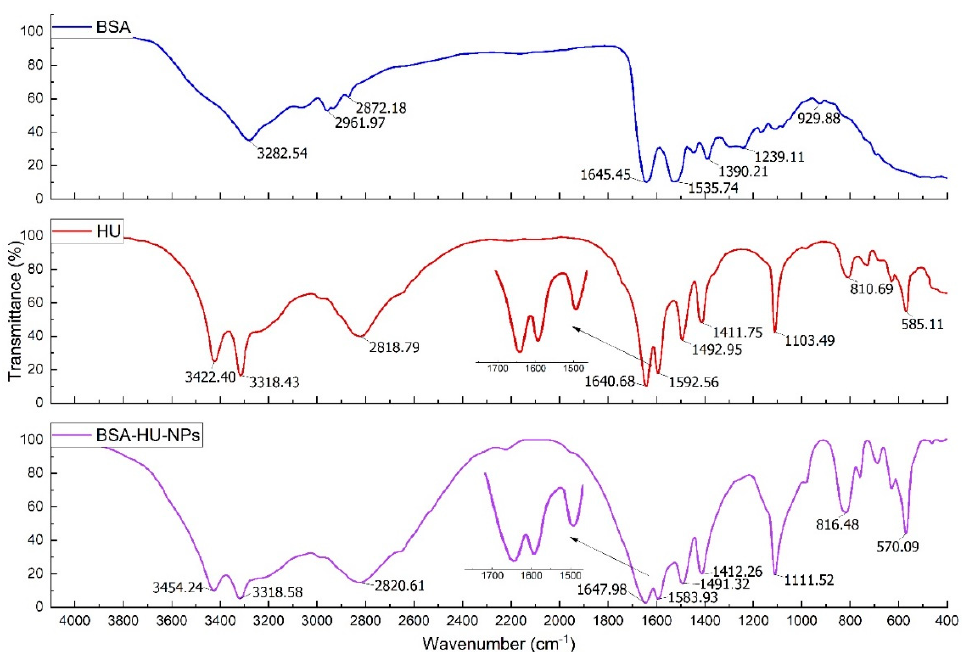
Figure 7. FTIR-Spectra of BSA, antitumor drug hydroxyurea (HU) and complex BSA-NPs with hydroxyurea.